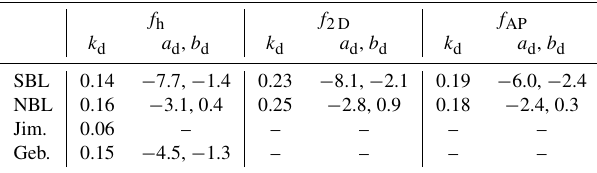
Table 3. Best fit parameters to the wake deflection output of the different methods using Gebraad et al. (2016), Eq. (12). Comparison with the results of the aforementioned study and with Jimenez et al. (2010). The parameter k d defines the recovery of the wake trajectory to the mean wind direction, and a d and b d the displacement due to the interaction of wind shear and rotation of the